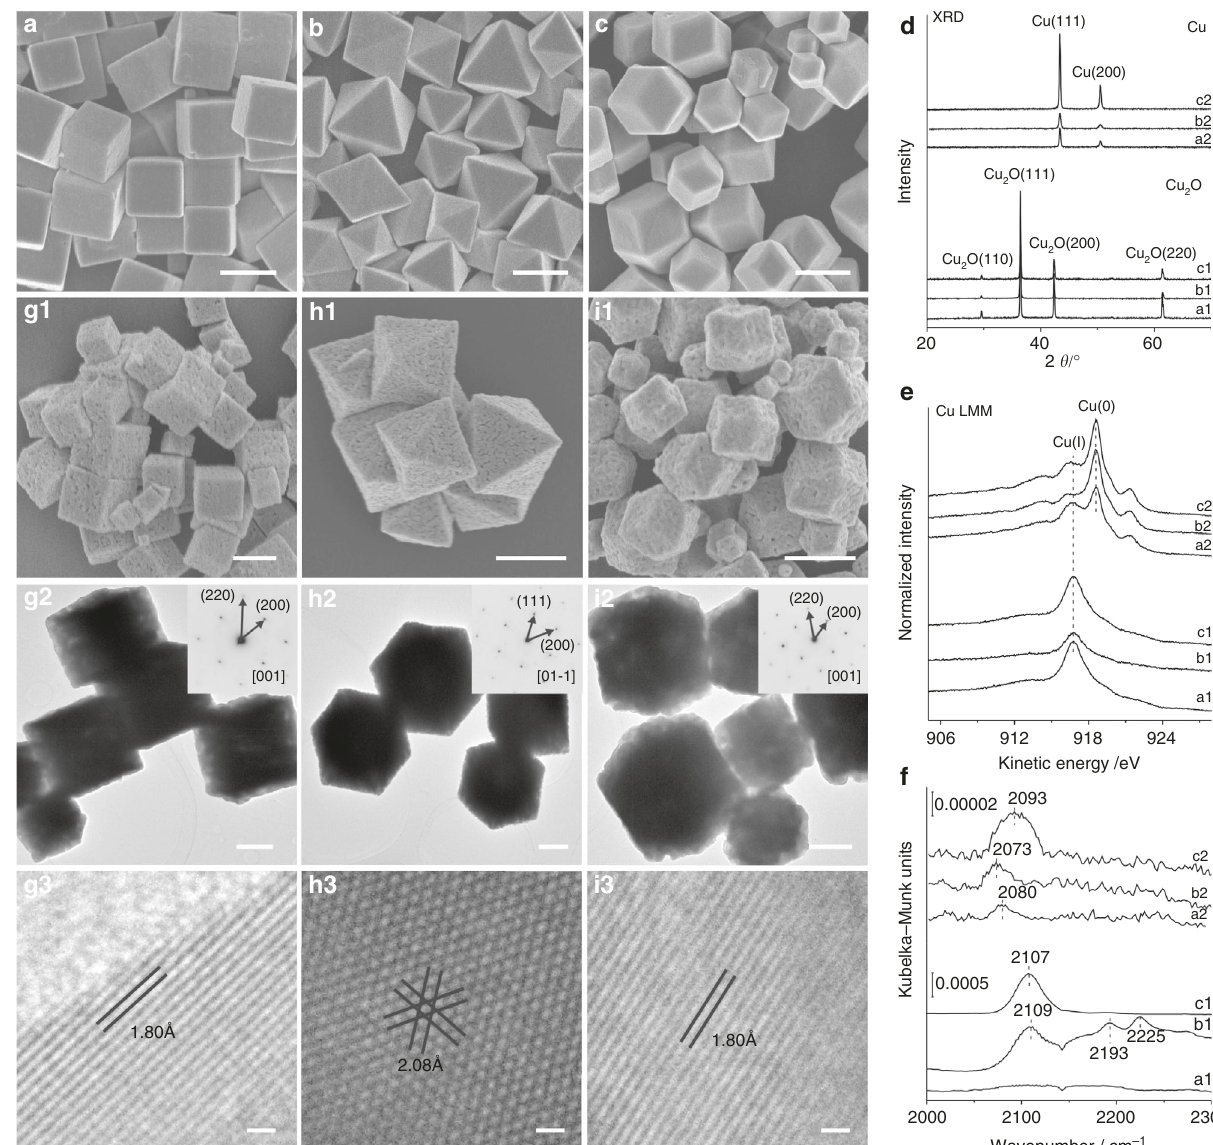
Fig. 1 Structural characterizations. The scale bars of a – c and ( g1 – i1 ) correspond to 1000nm, that of ( g2 – i2 ) correspond to 500 nm, and that of ( g3 – h3 ) correspond to 2 nm. Representative SEM images of a Cu 2 O cubes, b Cu 2 O octahedral, and c Cu 2 O rhombic dodecahedra. d XRD patterns, e Cu LMM AES spectra measured without exposure to air, and f in situ DRIFTS spectra of CO adsorption at 123 K of Cu 2 O cubes (a1), octahedra (b1), rhombic dodecahedra (c1) and Cu cubes (a2), octahedra (b2) and rhombic dodecahedra (c2). Representative SEM, TEM and HRTEM images of ( g1 – g3 ) Cu